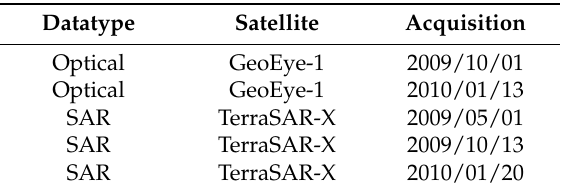
Table 1 describes satellite dataset used which consists of GeoEye-1 optical images (one pre- and one post-seismic), and three TerraSAR-X SAR images (two pre- and one post-seismic). Table 1. EO data list for NN training. Table 1. EO data list for NN training.